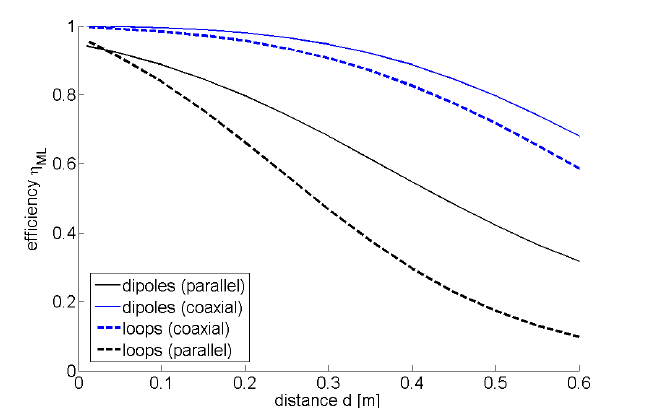
Figure 11. Matched-load efficiencies of the coaxial and parallel configurations of the loop = 46 . 1 MHz and l = 2 a = 0 . 3 and dipole systems operating at f 0